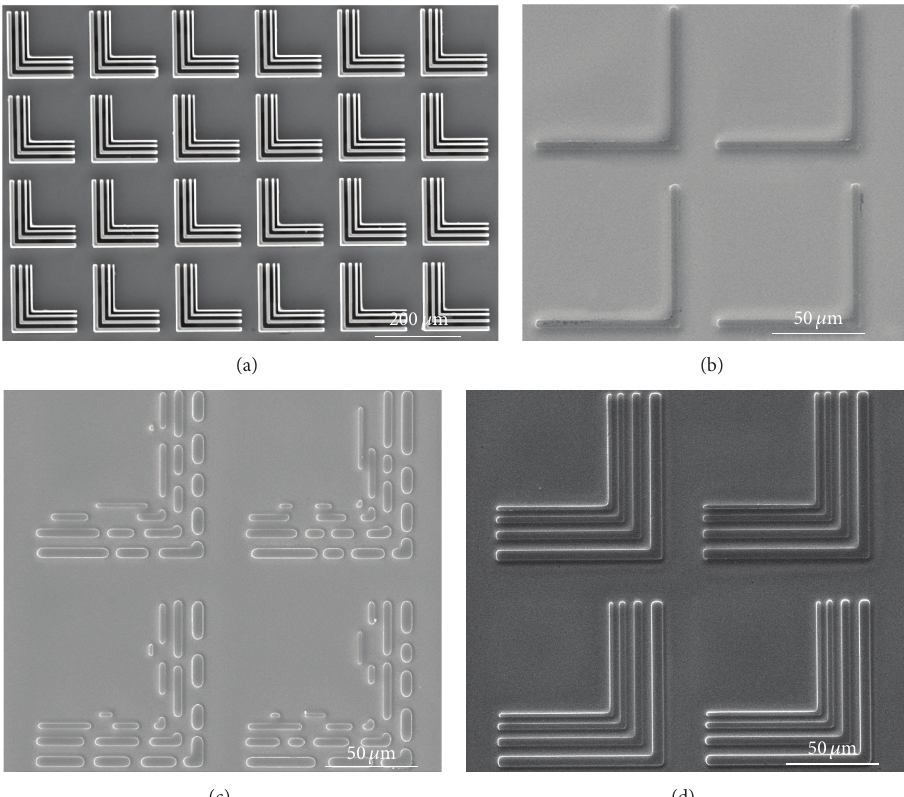
Figure 2: SEM images of the template with L-shaped line patterns and structures formed in EHD patterning. (a) The template, (b) the structures obtained with 30 V voltage, (c) the structures obtained with 80 V voltage, and (d) the structures obtained with 50 V